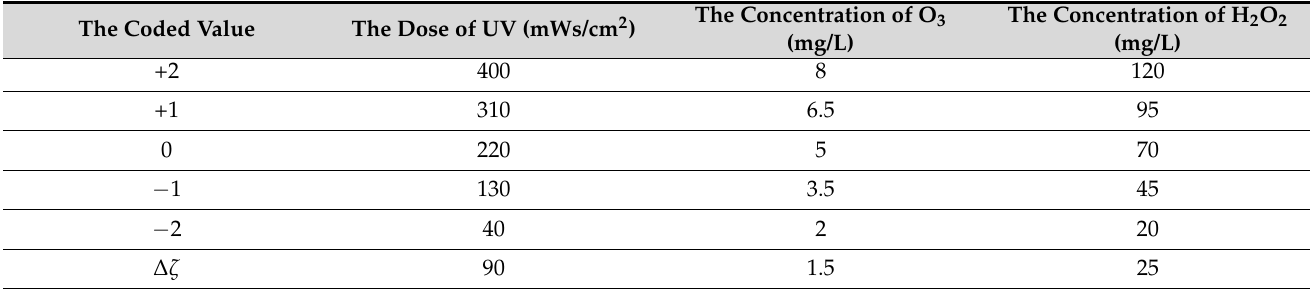
Table 1. The real values associated with each coded value in Minitab software 16.